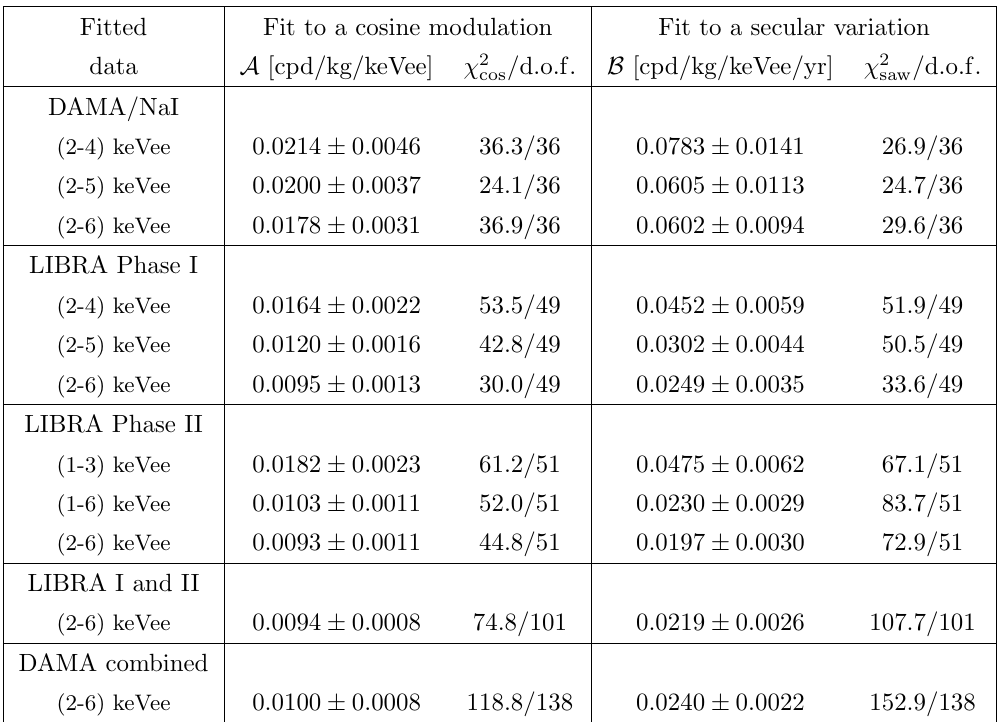
Table 1 . Best-(cid:12)t values of the DM cosine amplitude A and the sawtooth coe(cid:14)cient B obtained by (cid:12)tting the DAMA residuals in di(cid:11)erent energy intervals, together with the corresponding (cid:31) 2 = d.o.f. Our (cid:12)ts of the cosine amplitudes agree with those reported by DAMA/LIBRA .